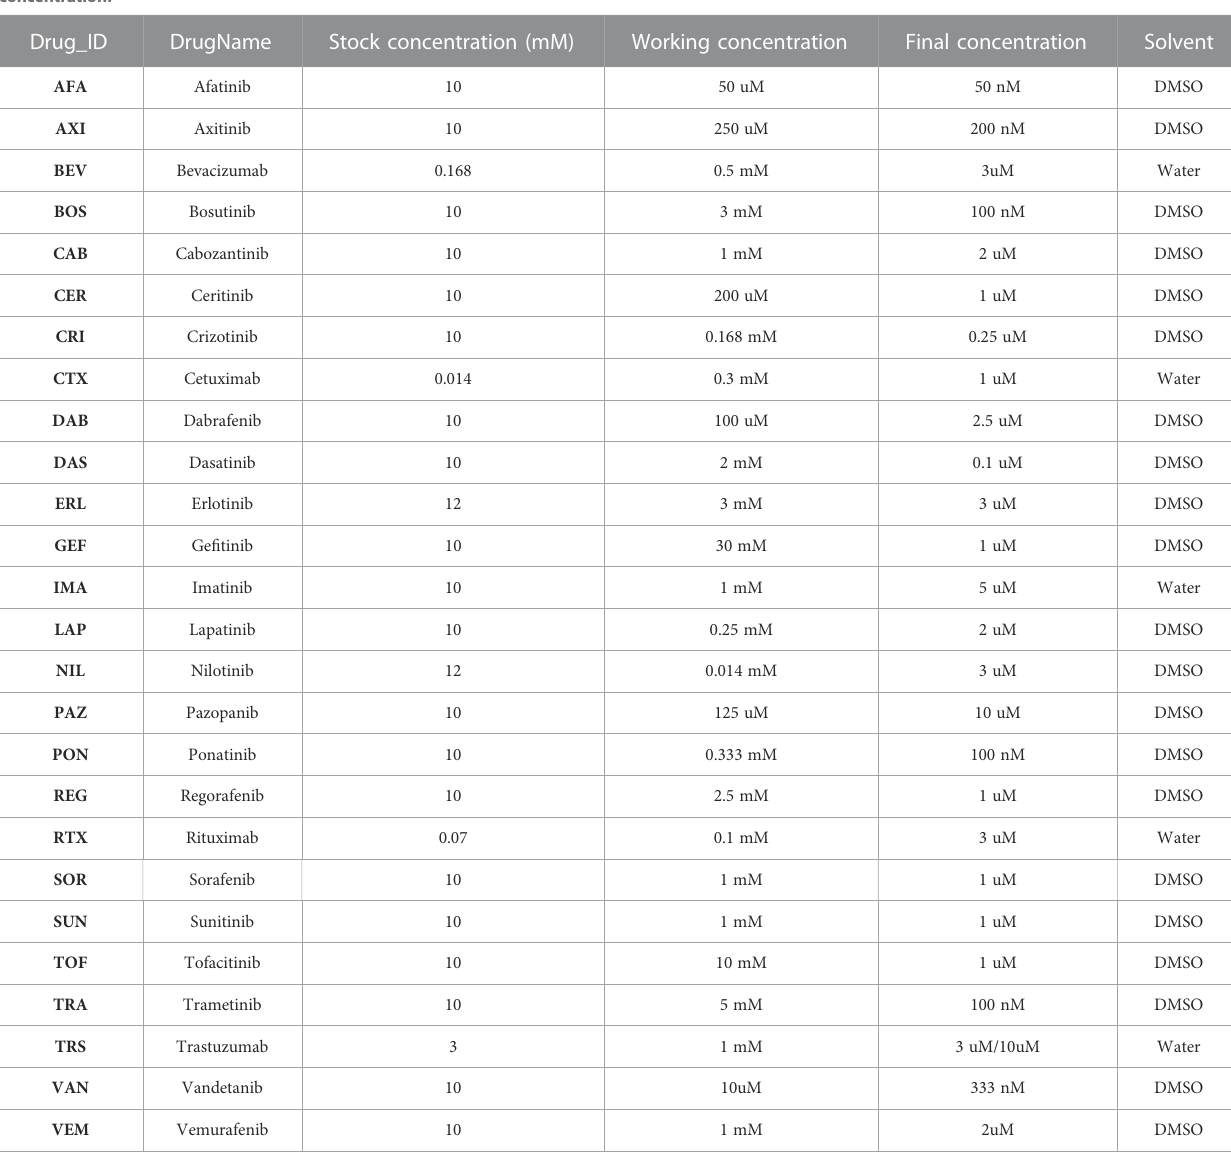
TABLE 1 TKI treatment concentration and the solvent information. The stock solution of each TKI was diluted to the working concentration using the correspondingsolvent. Theappropriateamount ofworkingconcentrationwasthenaddedtothe mediainthePetri dishcontainingiPSC-CMs toarrive tothe fi nal